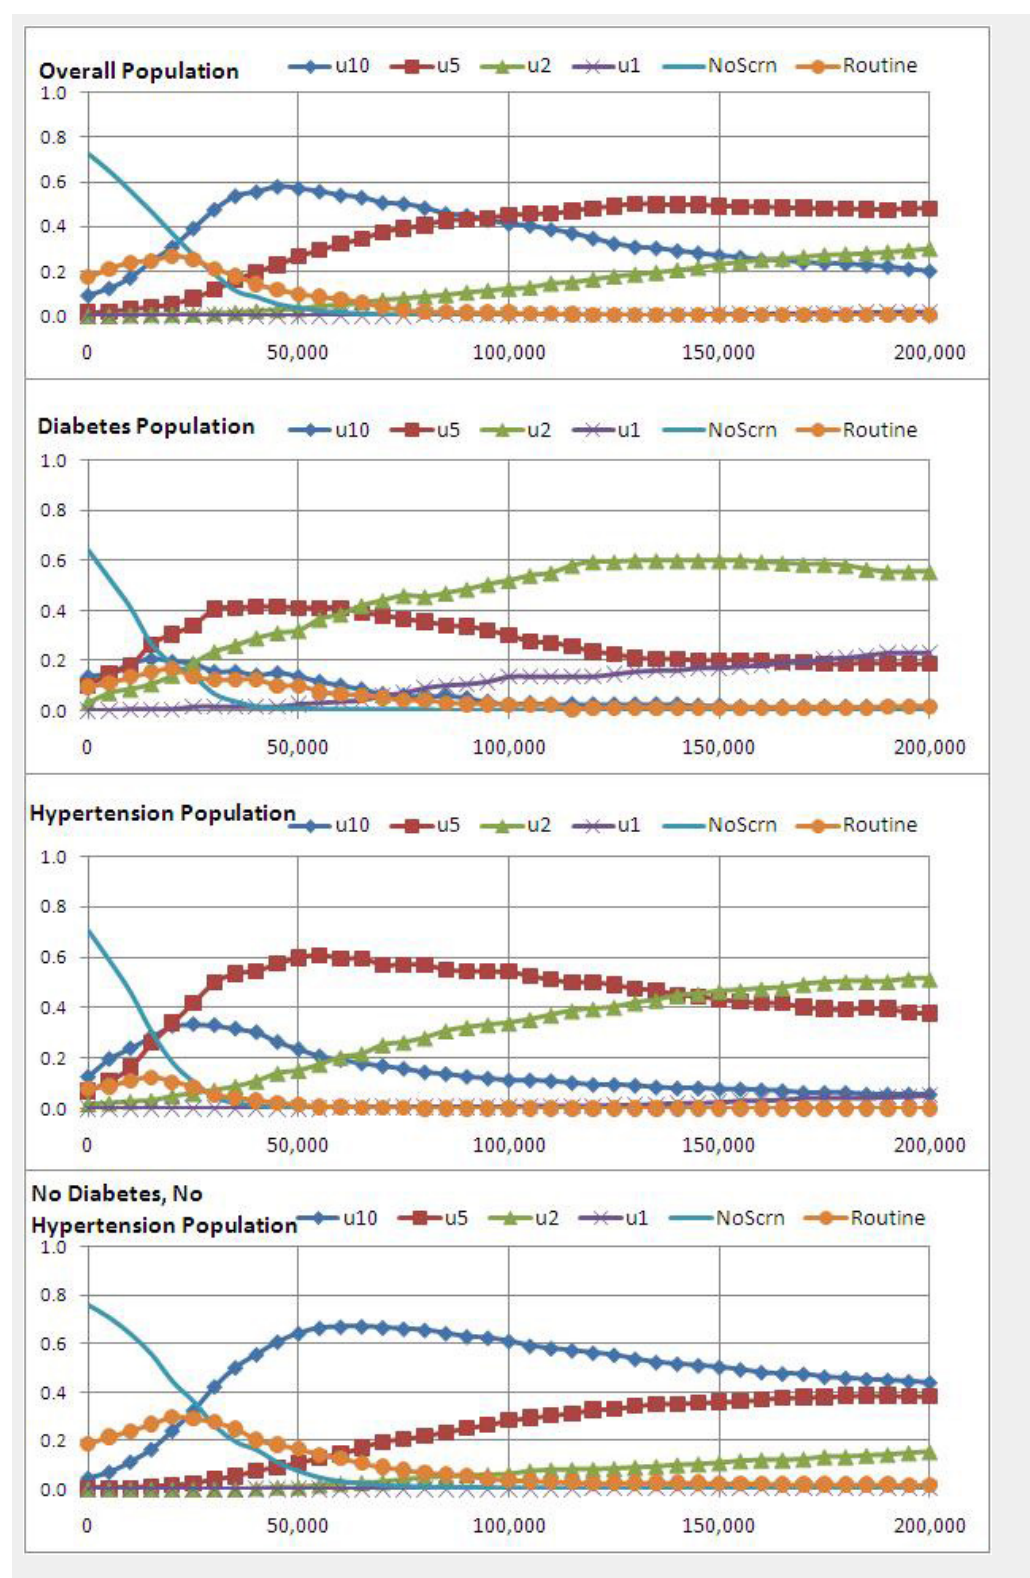
Figure 3 Cost-effectiveness Acceptability Curves. U10: screening at 10-year interval, u5: screening at 5-year interval; u2: screening at 2-year interval: u1 annual screening; Noscrn: No screening scenario; Routine: usual care scenario Cost-effectiveness acceptability curves show the probability of each scenario having the highest net monetary benefits (y-axis) based on willingness to pay from 0 CHF to 200,000 CHF